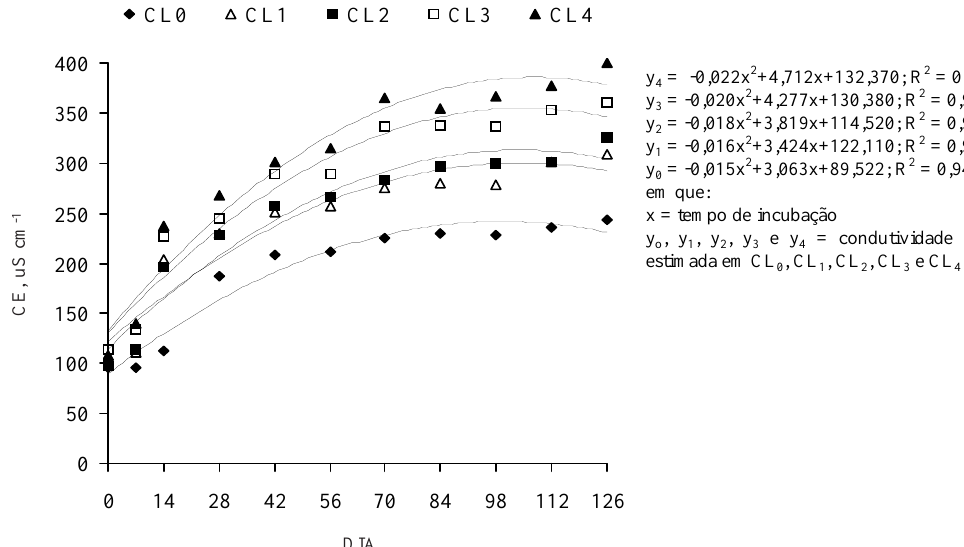
Figura 6. Condutividade elétrica no solo, considerando o tempo de incubação, no tratamento não adubado (CL ) e nos adubados com 30 (CL 0